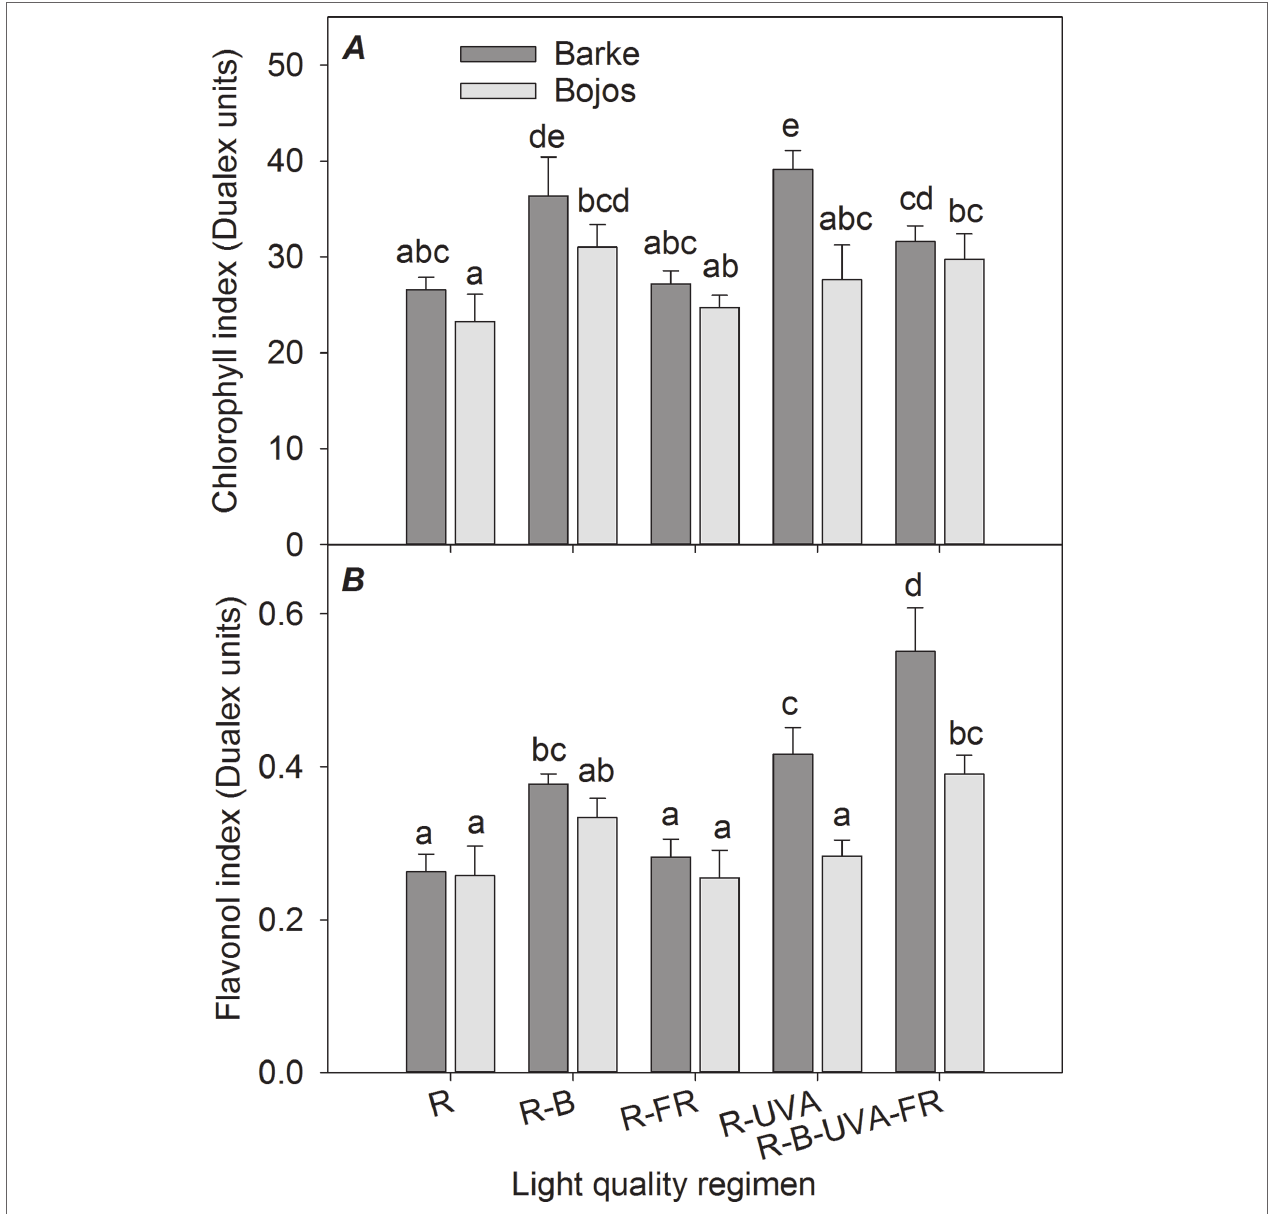
FIGURE 3 | Effect of 26 days exposure to different light regimens on chlorophyll index (A) and flavonol index (B) of spring barley varieties Barke (dark grey) and Bojos (light grey). Additional details are in the Figure 1